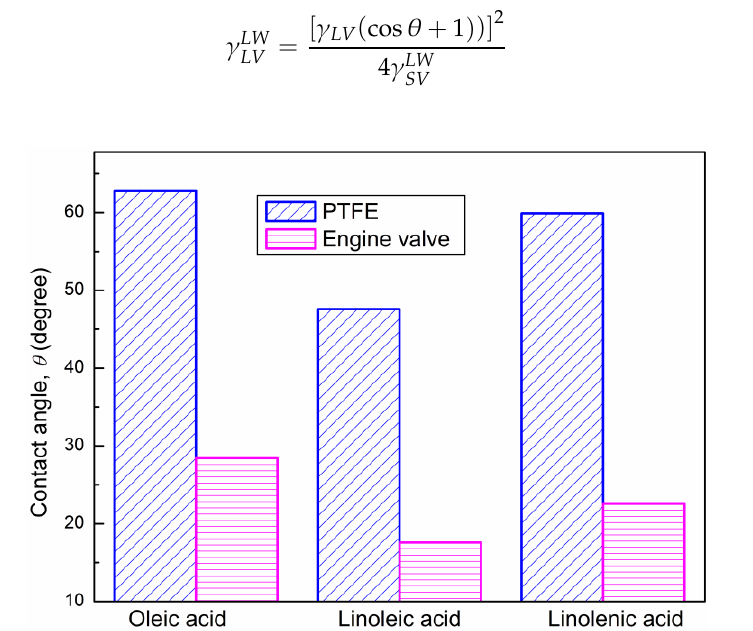
Figure 2. Values of the contact angle ( θ ) for oleic, linoleic, and linolenic acids on the polytetrafluoroethylene (PTFE) and engine valve surface.